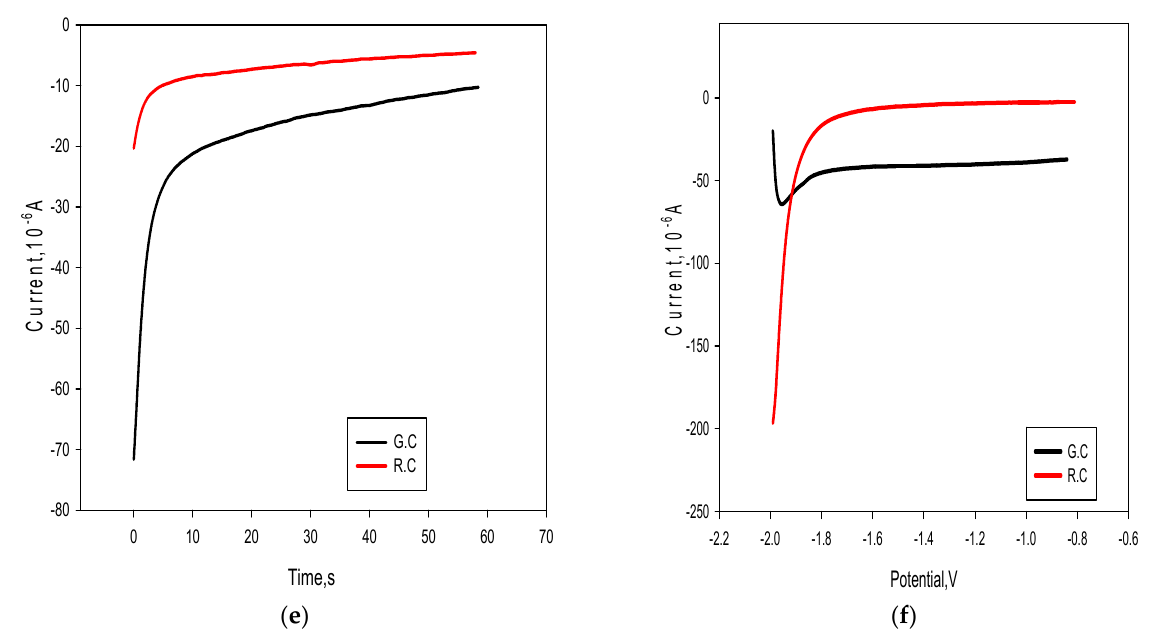
Figure 8. Cyclic voltammetry curves of GC and RC extracts. ( a ) Current/potential of RC extract ( b ) Current/potential of GC extract ( c ) higher reversibility and faster redox reactions of GC and RC extracts ( d ) Effect of scan rate increment on GC and RC extracts ( e ) Amperometric charge curves of GC and RC extracts ( f ) Amperometric discharge curves GC and RC extracts.